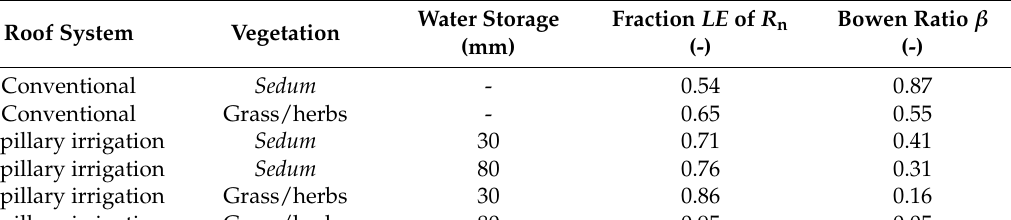
Table 2. Long-term annual mean latent heat flux (LE) fractions of R n and Bowen ratio’s for six system layouts.